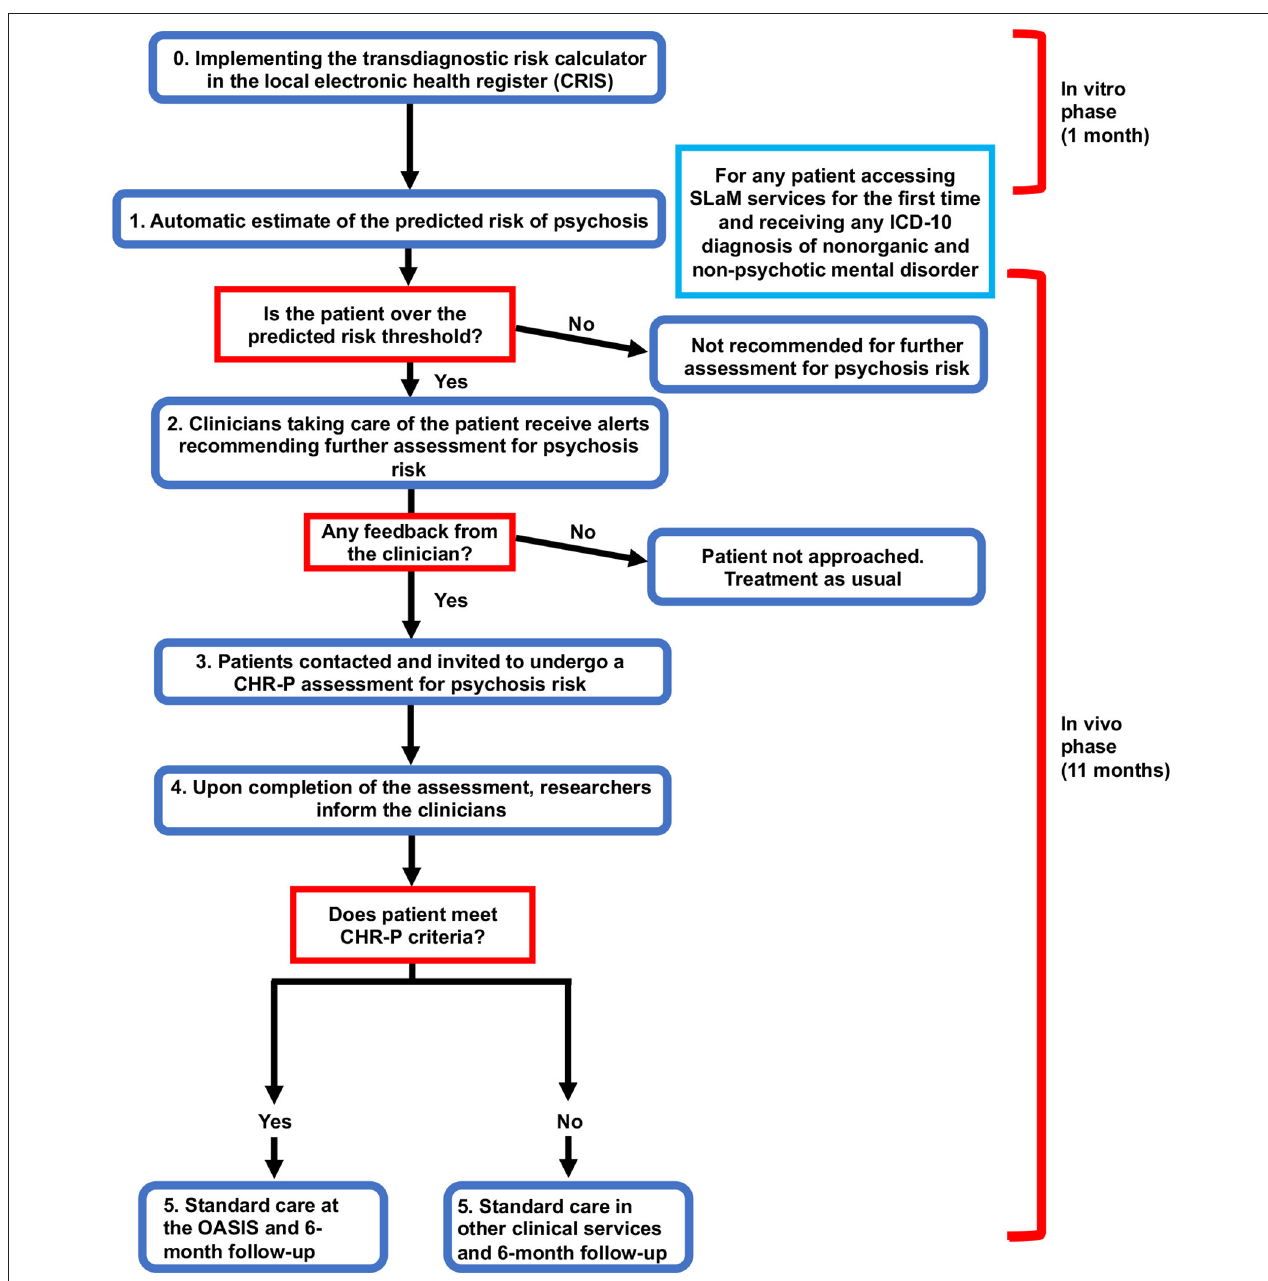
FIGURE 3 | Flow chart of study design including the in-vitro and in-vivo